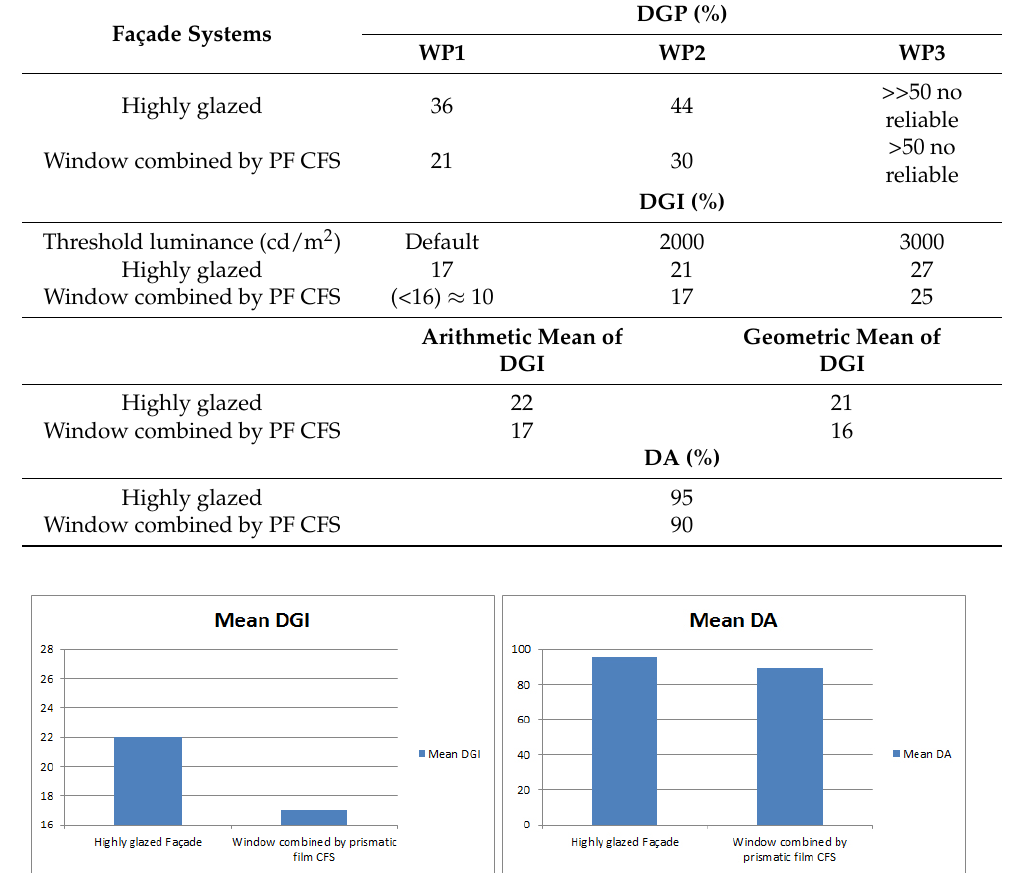
Table 5. DGP and Daylight Autonomy (DA) results for highly glazed façade system and window combined by prismatic film CFS façade system, with medium quality images.